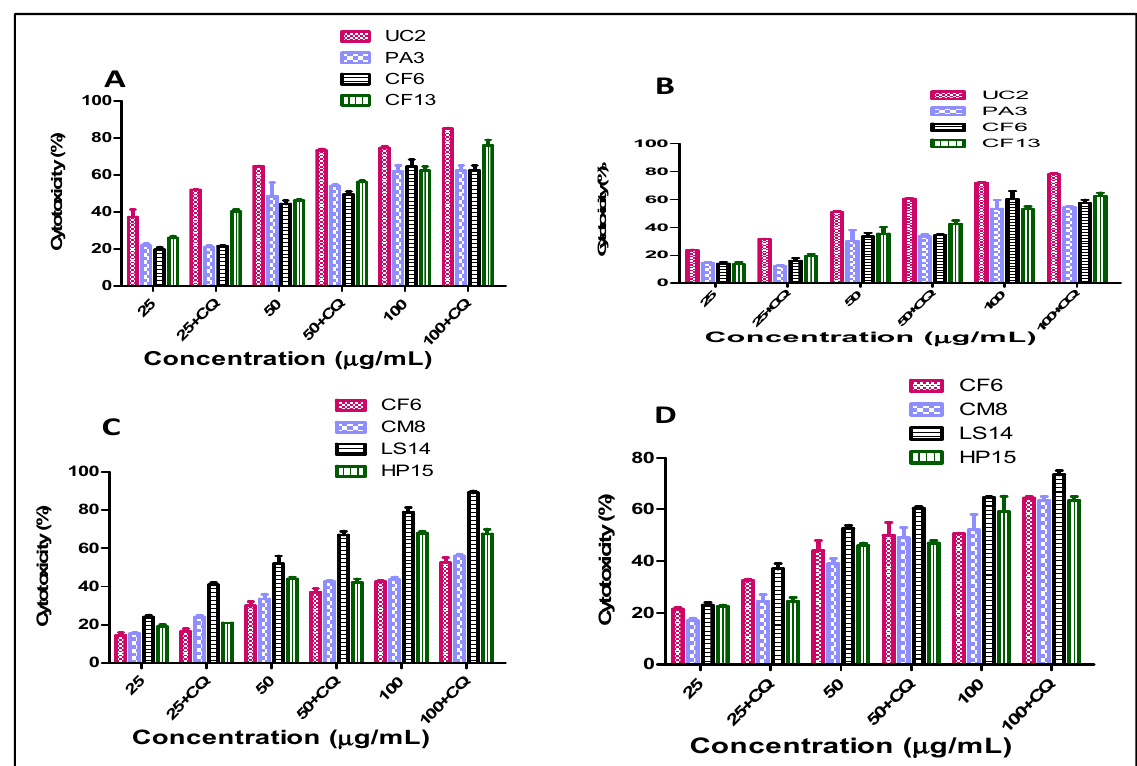
Figure 2. Cytotoxicity of selected lichen extracts in the presence of an autophagy inhibitor, chloro- quine (CQ), observed via MTT assays after 24 h of treatment; ( A ) selected lichen acetone extract against HeLa cells (+/ − CQ); ( B ) selected lichen acetone extract against MCF-7 cells (+/ − CQ); ( C ) selected lichen hexane extract against HeLa cells (+/ − CQ); ( D ) selected lichen hexane extract against MCF-7 cells (+/ − CQ). Values are the means ± SDs of three independent experiments. Table 2. (A) Cytotoxicity of selected lichen acetone extracts (IC 50 ) against HeLa and MCF-7 cells in the presence and absence of the autophagy inhibitor chloroquine (CQ) after 24 h of treatment. (B) Cytotoxicity of selected lichen hexane extracts (IC 50 ) against HeLa and MCF-7 cells in the presence and absence of the autophagy inhibitor chloroquine (CQ) after 24 h of treatment. (A)